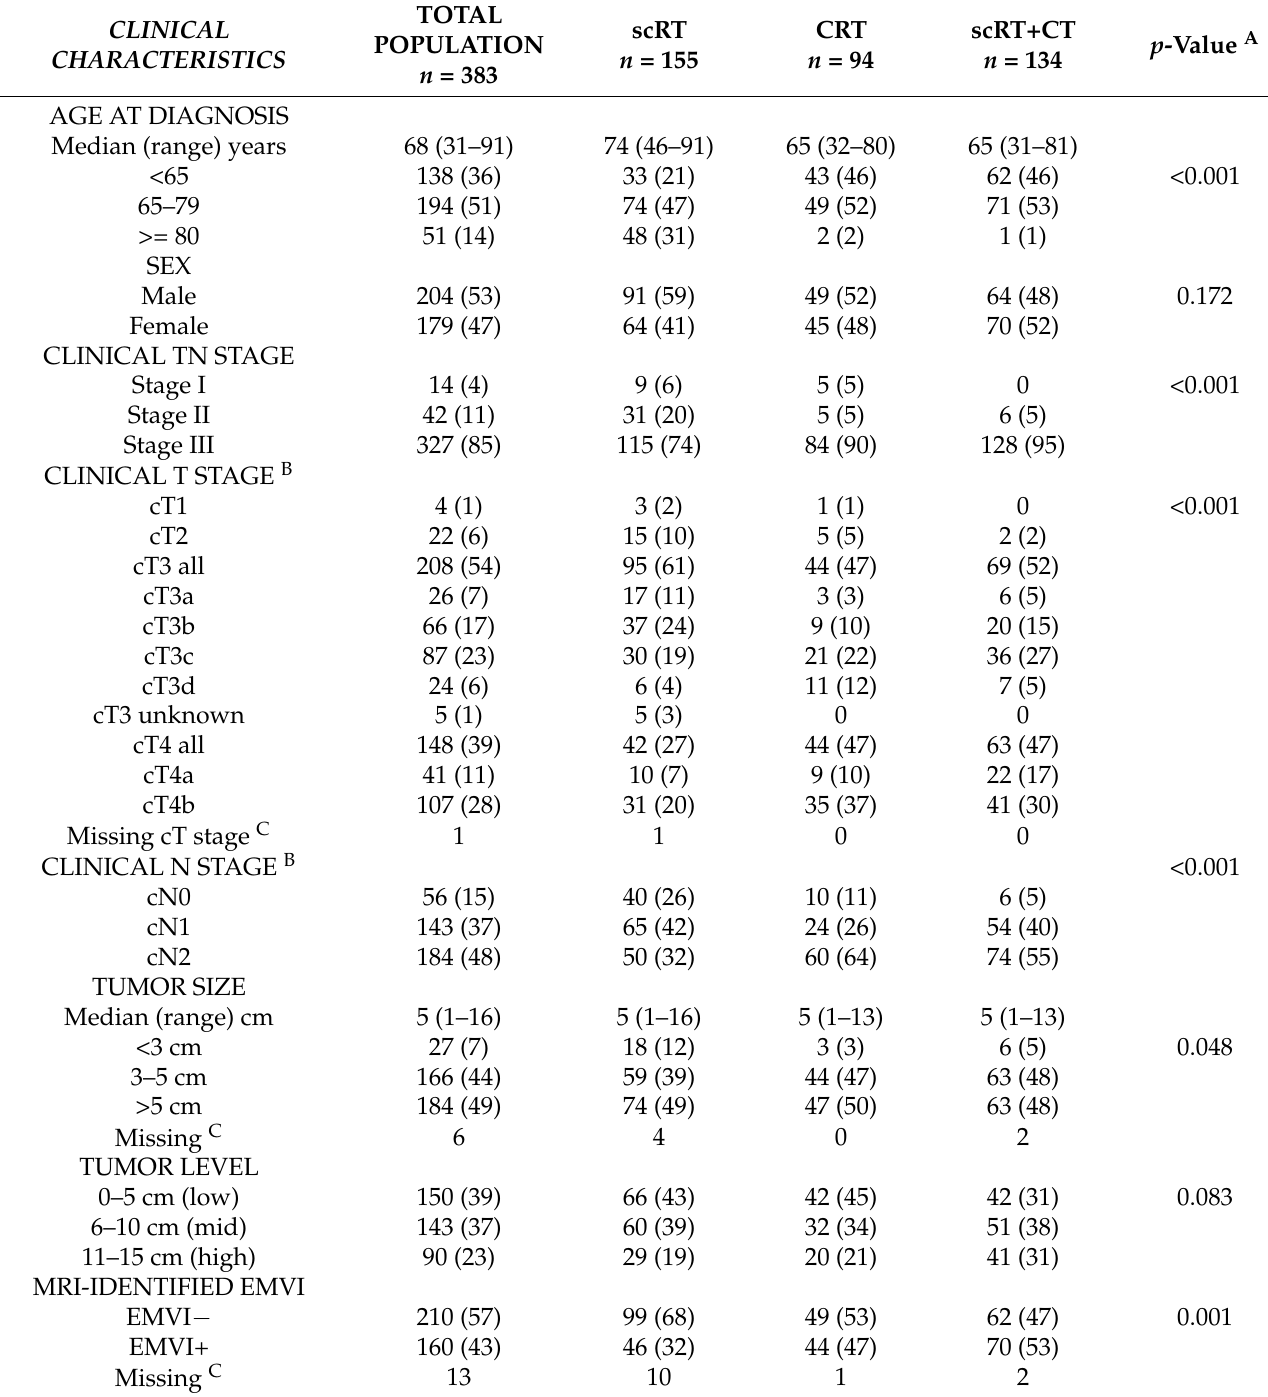
Table 1. Clinical T and N stage, MRI characteristics and laboratory values routinely considered at diagnosis and treatment response according to treatment of non-metastatic rectal cancer